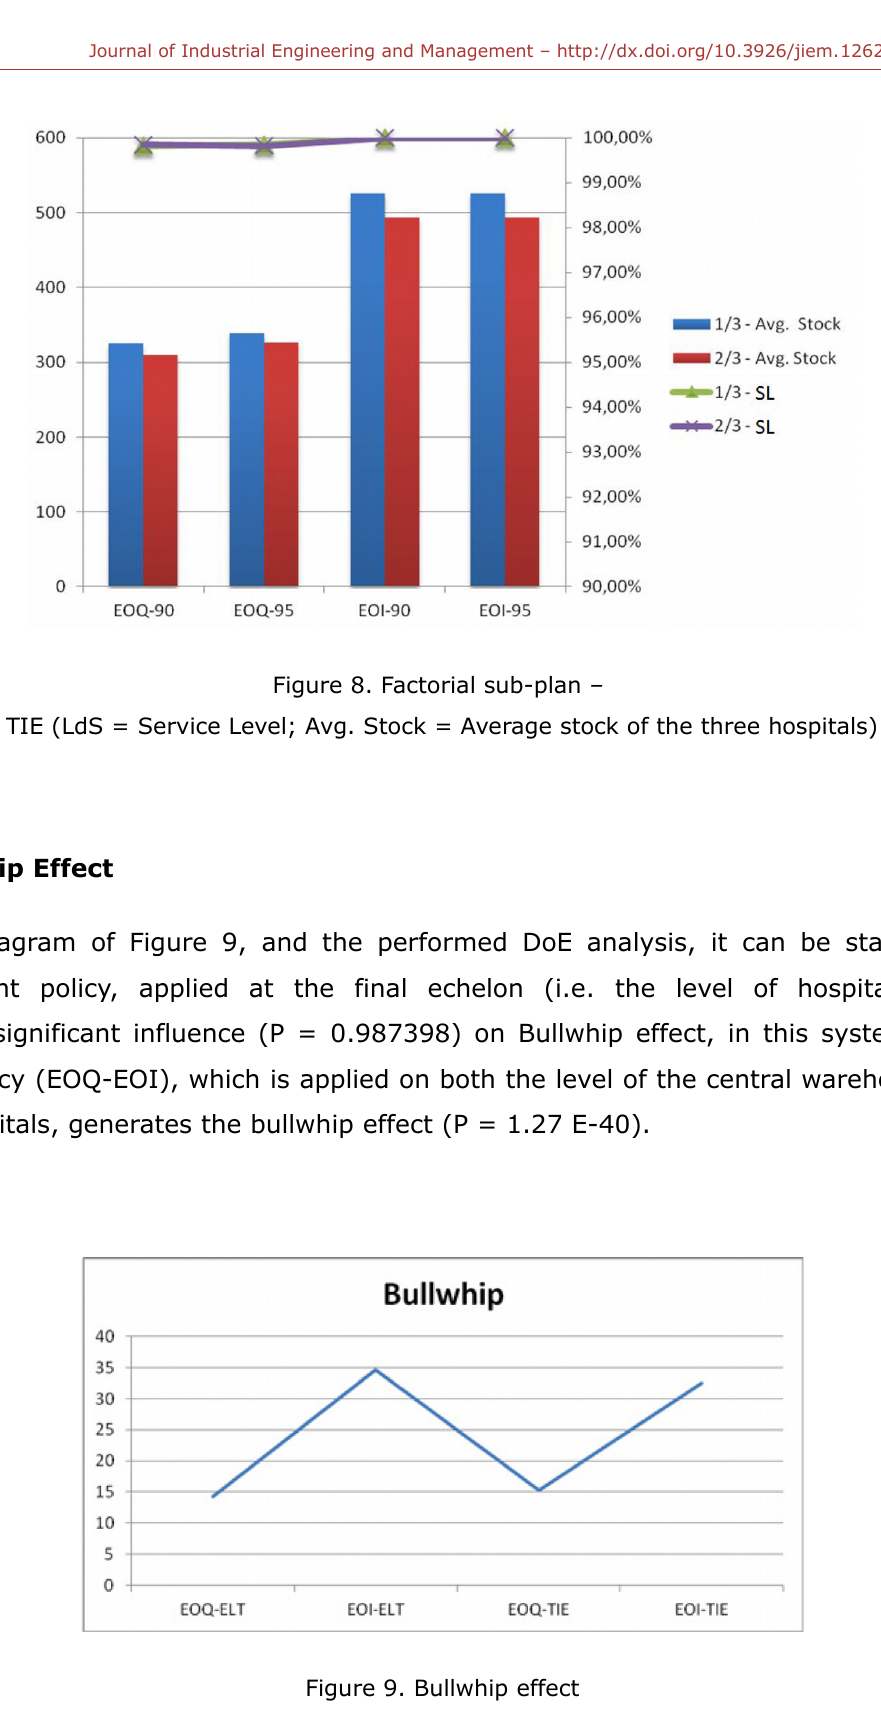
Figure 9. Bullwhip